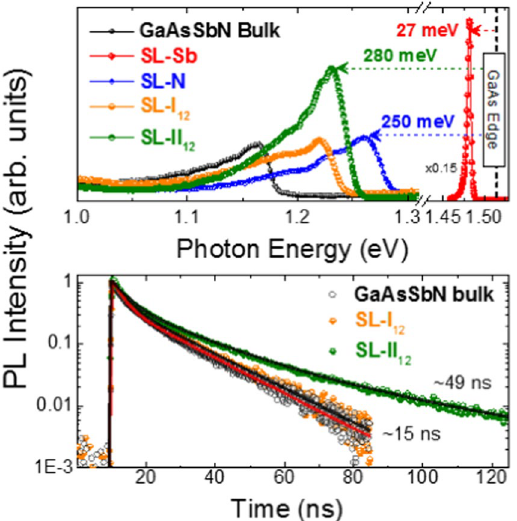
Figure 3. Photoluminescence and time-resolved photoluminescence of the different structures. ( a ) Time- integrated PL spectra of all the samples taken at low temperature (15 K) with a fixed laser power of 3 mW. The indicated energies in meV represent the energy shift of the PL peak energy of each sample with respect to the GaAs bandgap (1.46 eV). ( b ) Time-resolved PL decay curves of the samples bulk , SL-I and SL-II , each one measured at the energy corresponding to the PL peak taken from the spectra in ( a ). Solid lines represent the result of a multi-exponential fit to the experimental data. The (longer) radiative times obtained from this fitting are indicated in the figure. The complete deconvoluted decay time parameters are presented in Supplementary Table